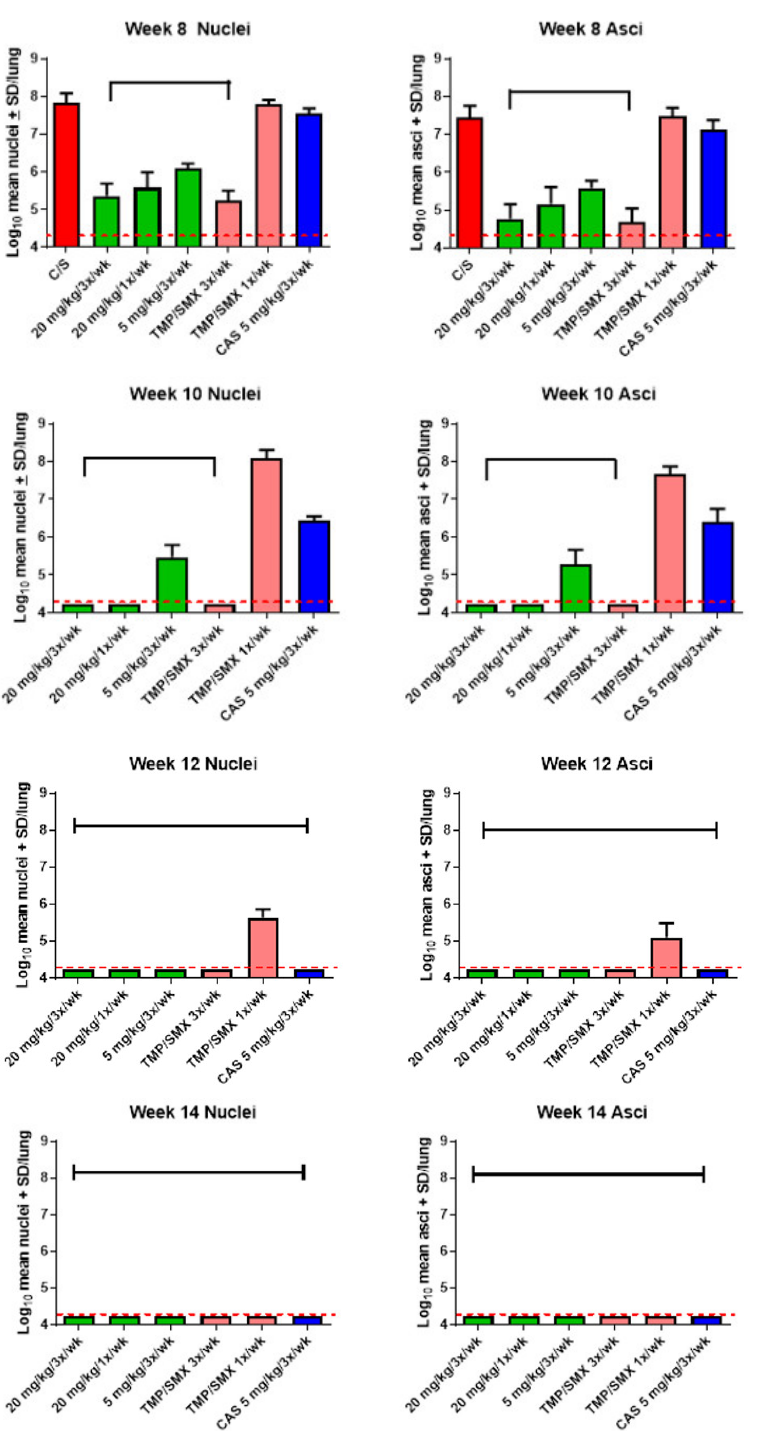
Figure 1. Log10 mean nuclei and asci counts after 2 to 8 weeks of prophylactic treatment followed by additional 6 weeks of immunosuppression without treatment. Color code: red = C/S; vehicle treated negative control; green = rezafungin; pink = T/S (trimethoprim/sulfamethoxazole), blue = CAS (caspofungin). Bracket denotes significant difference from week 8 C/S group and CAS group ( p < 0.05). Capped line indicates significant difference from week 8 C/S group. Red dotted line indicates limit of microscopic detection (log 10 4.24).